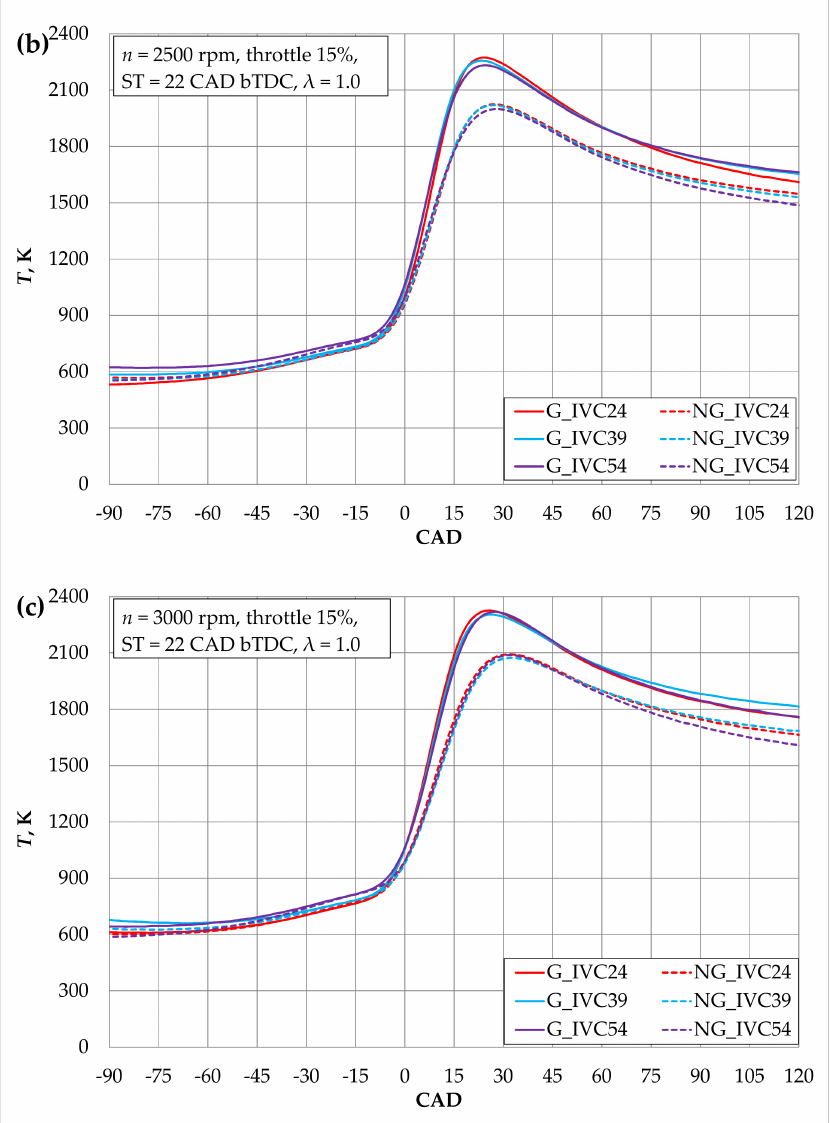
Figure 10. Combustion temperature in the cylinder with the engine running on gasoline and natural gas and while changing the intake valve close timing: ( a ) 2000 rpm; ( b ) 2500 rpm; and ( c ) 3000 rpm.